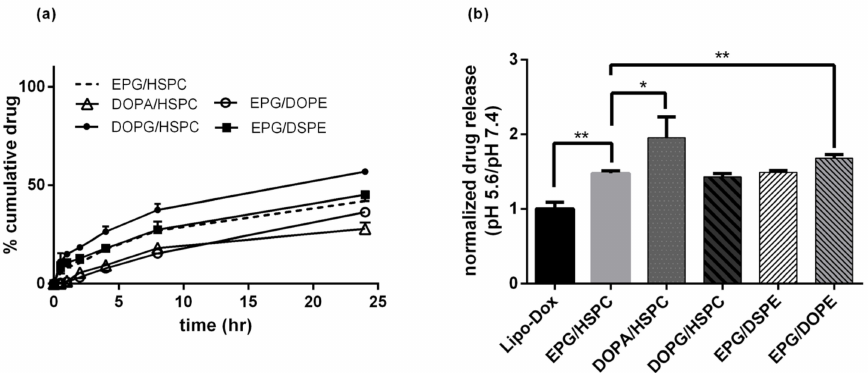
Figure 5. ( a ) In vitro drug release of LNC-Dox with different lipid compositions in PBS. ( b ) Normal- ized drug release of LNC-Dox with different lipid compositions (* p < 0.05; ** p < 0.01). Data are expressed as the mean ± SD ( n =